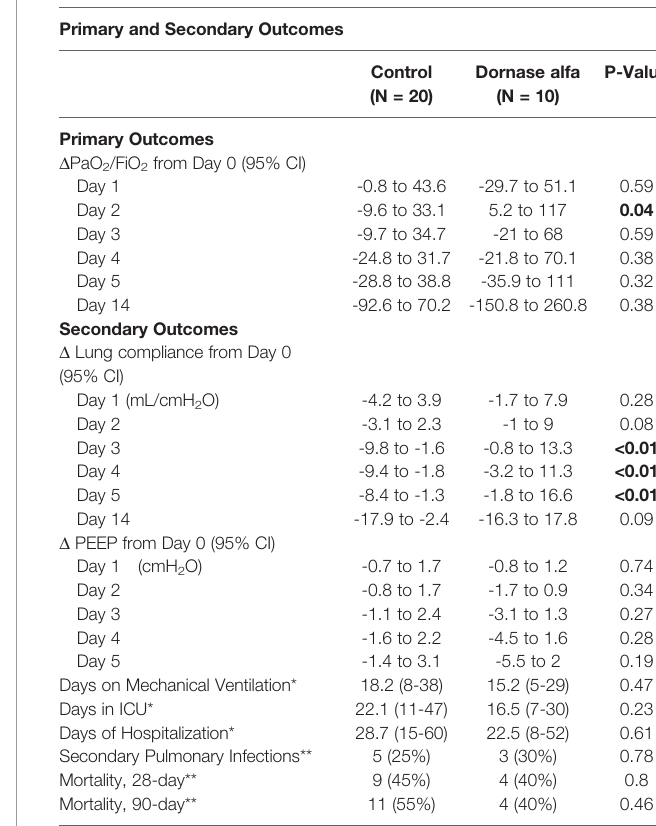
TABLE 2 | Primary and Secondary Outcomes of patients in case-control group (N=20) and Dornase alfa treatment group